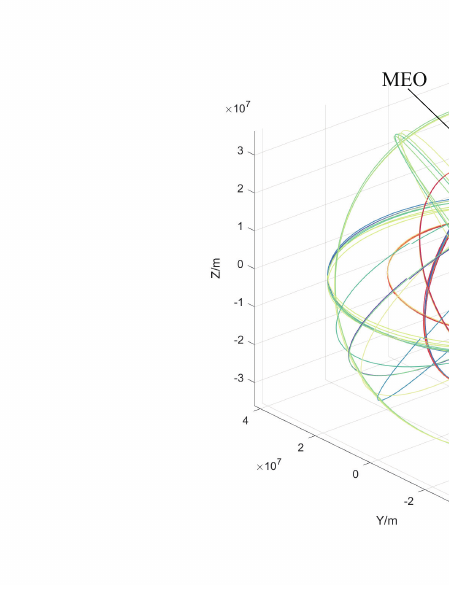
Figure 2. This is the Beidou navigation constellation map under J2000.0 geocentric inertial coordinate